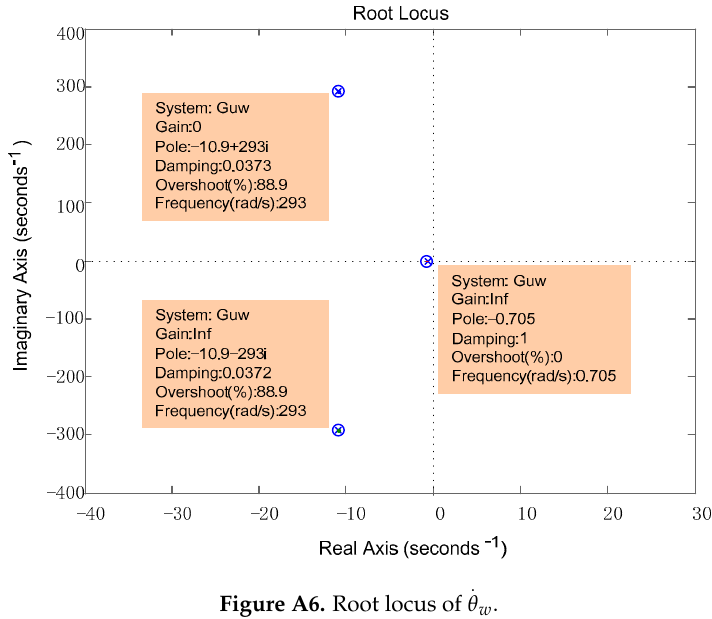
Figure A6. Root locus of FigureA6. Root locus of